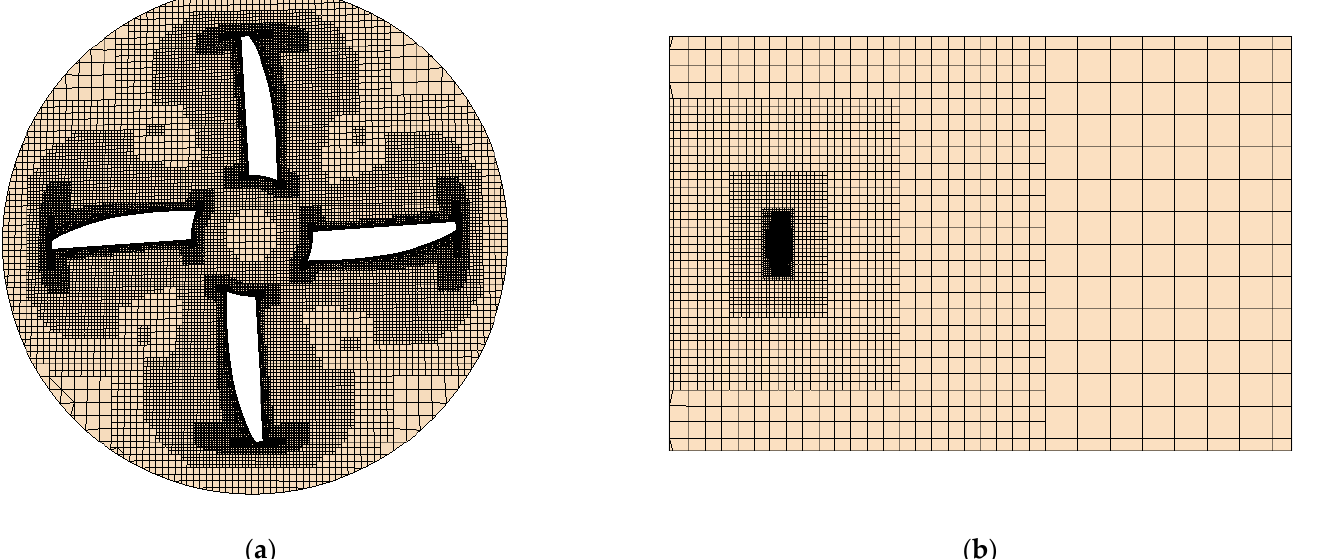
Figure 4. Propeller meshing diagram: ( a ) X section grid; ( b ) Y section grid.